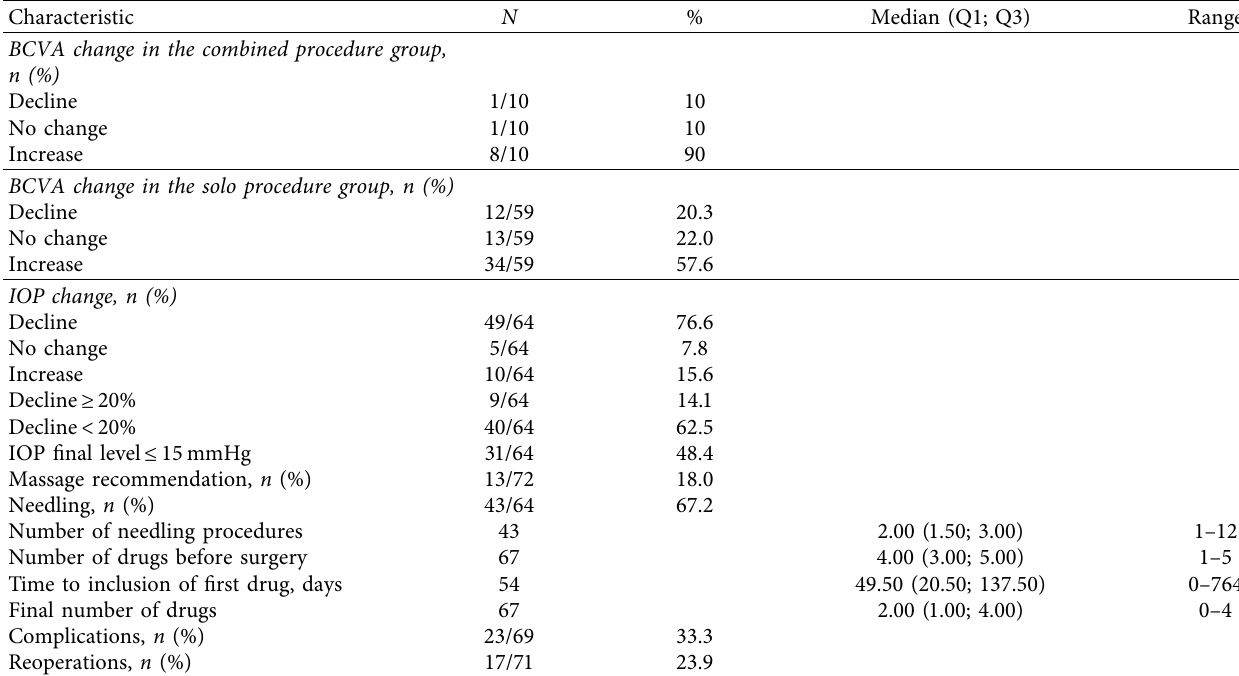
Table 3: Clinical characteristics of the study group.